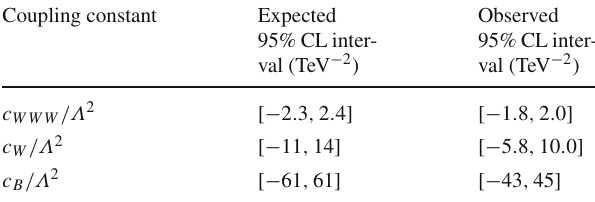
Table 5 One-dimensional limits on the ATGC EFT parameters at 95% CL from the combination of EW Wjj and EW Zjj analyses Coupling constant